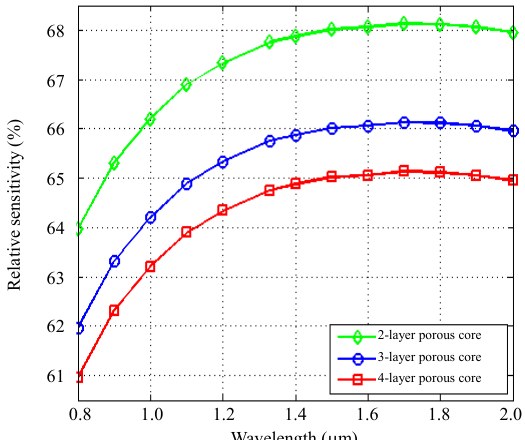
Fig. 3 Comparison of the relative sensitivity with core layer variations for n